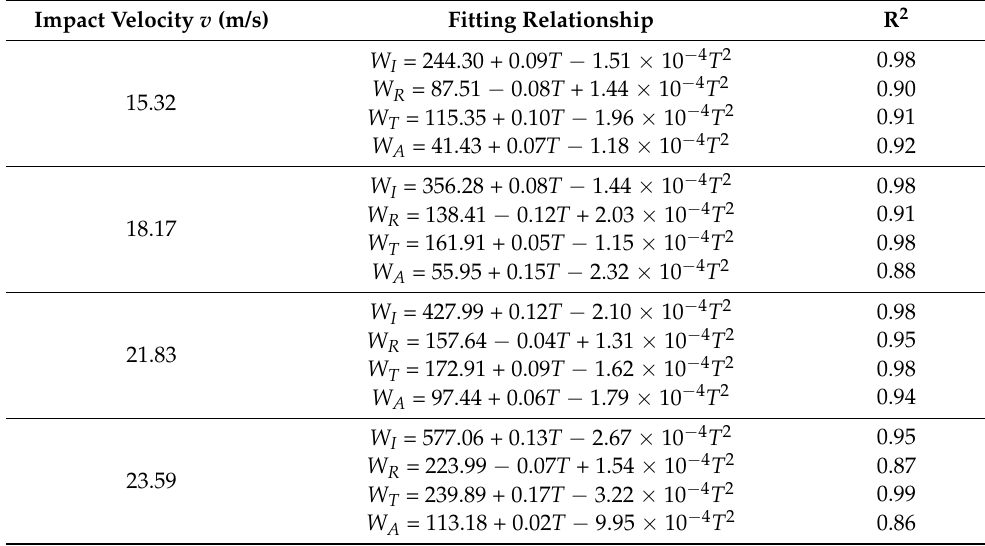
Table 2. Fitting relationship between temperatures and energies at different impact